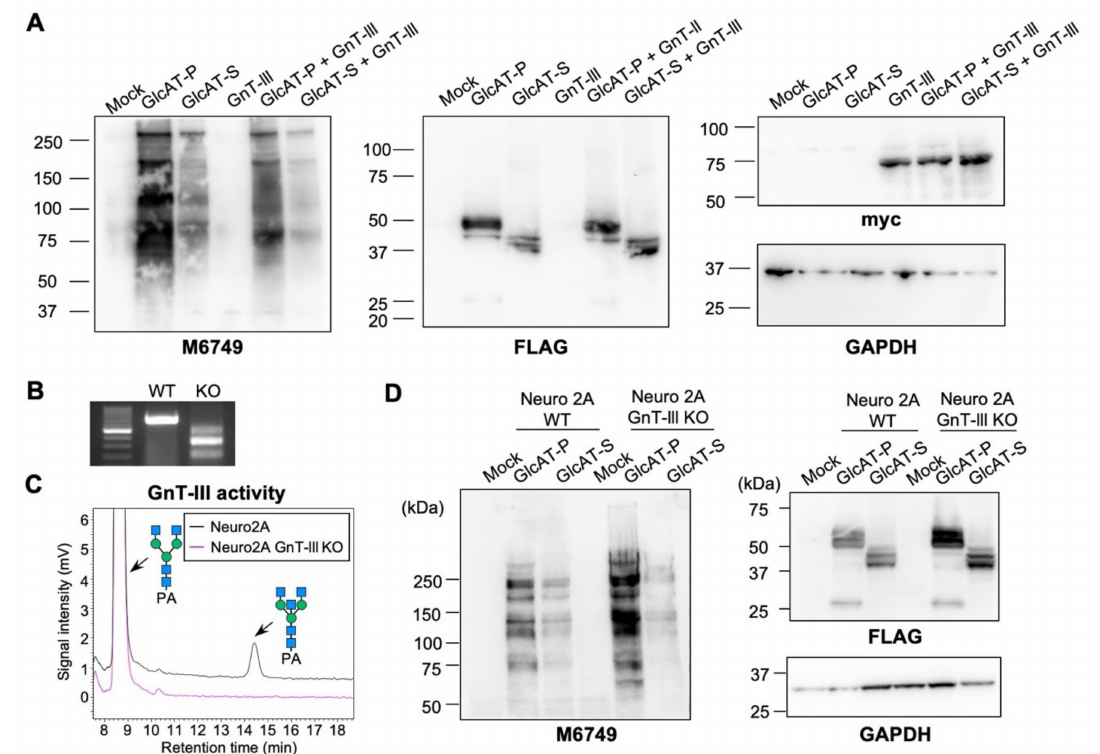
Figure 3. Effects of GnT-III overexpression or deletion on the intracellular activity of GlcAT-P and -S in cultured cells. ( A ) HEK293 cells were co-transfected with an expression plasmid for 3xFLAG-GlcAT-P or 3xFLAG-GlcAT-S, or an empty vector (Mock) with an expression plasmid for GnT-III or an empty vector. Cellular proteins were blotted with M6749 mAb, anti-FLAG M2 mAb, anti-Myc Ab, and anti-GAPDH Ab. ( B ) Genotyping PCR for the Mgat3 gene using genomic DNA from WT and GnT-III KO Neuro2A cells. ( C ) GnT-III activity of WT and GnT-III KO Neuro2A cells was measured. Cell lysates were incubated with the acceptor substrate GnGnbi-PA, and the reaction mixtures were analyzed by reverse-phase HPLC. ( D ) WT and GnT-III KO Neuro2A cells were transfected with an expression plasmid for 3xFLAG-GlcAT-P or 3xFLAG-GlcAT-S, or an empty vector (Mock). Cellular proteins were blotted with M6749 mAb, anti-FLAG M2 mAb, and anti-GAPDH